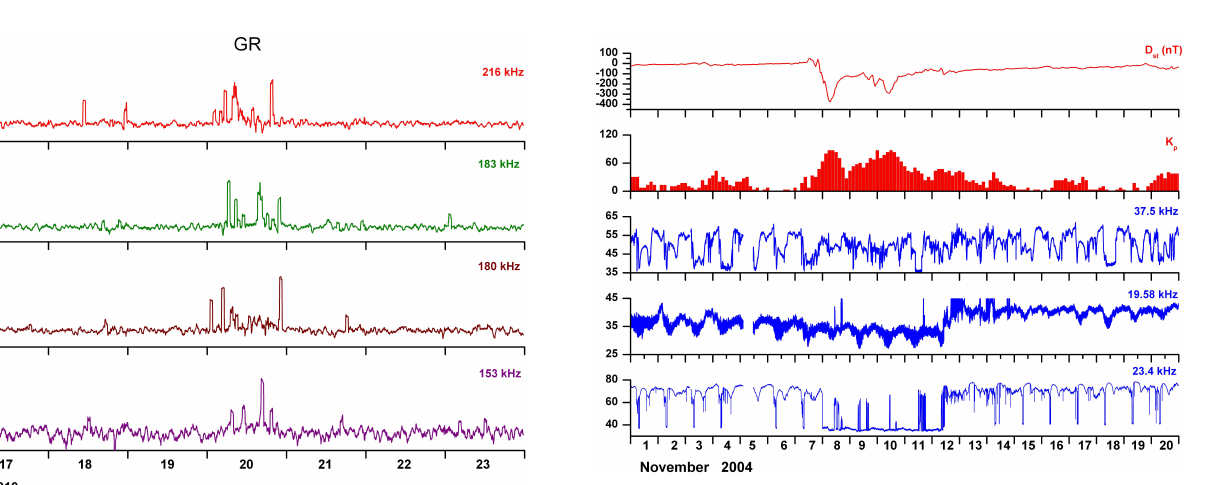
Fig. 11. Daytime intensity of the RRO (153kHz), TRT (180kHz), EU1 (183kHz) and MCO (216kHz) radio signals collected by the GR receiver during 17–23 June 2010. The data are copied by the raw set selecting each day the time interval from 09:00 a.m. to 02:00 p.m. (UT). An evident increase appears on all the trends on 20 June, a day characterized by an intense summer storm.